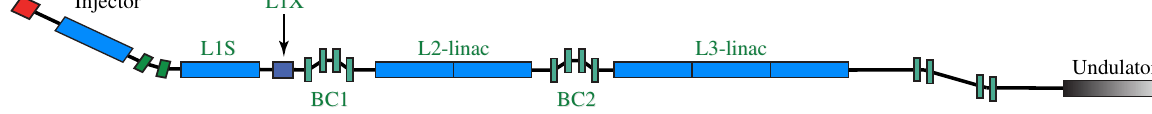
FIG. 10. A layout of the LCLS FEL is shown with the parameters being tuned highlighted in green. The electron pulse enters on the left end, is accelerated to high energy and then used to create light at the right end. The laser ’ s output power is measured after the undulator at the end of the machine.